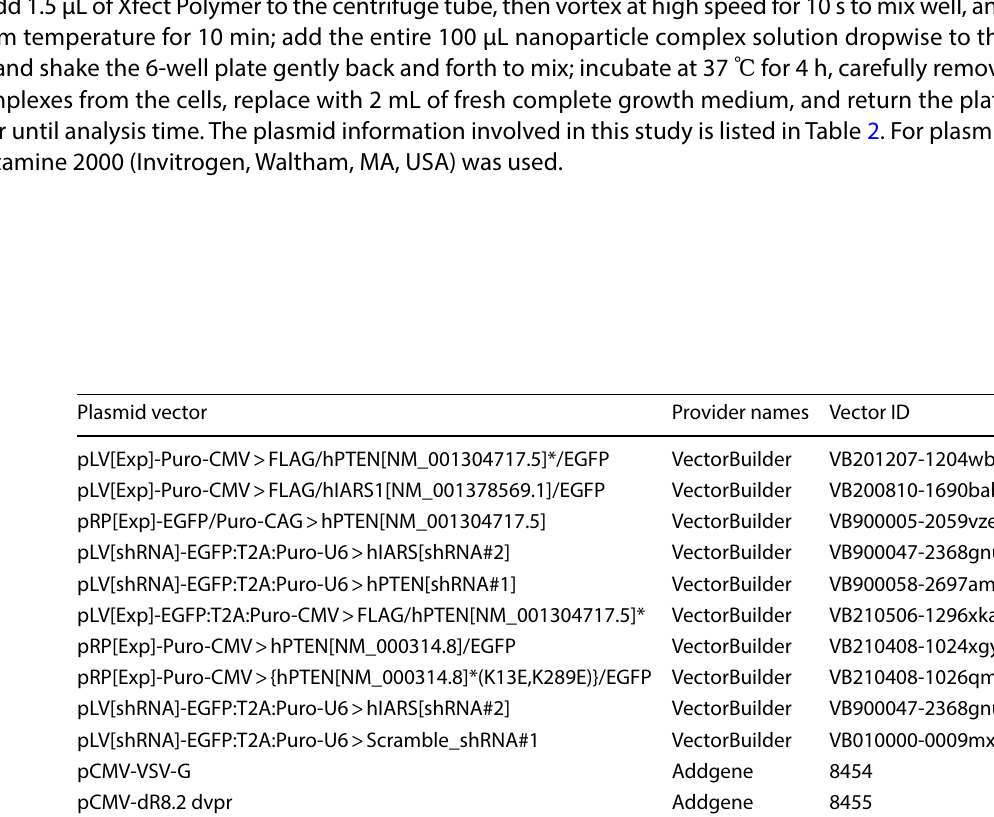
Table 2 The plasmid information